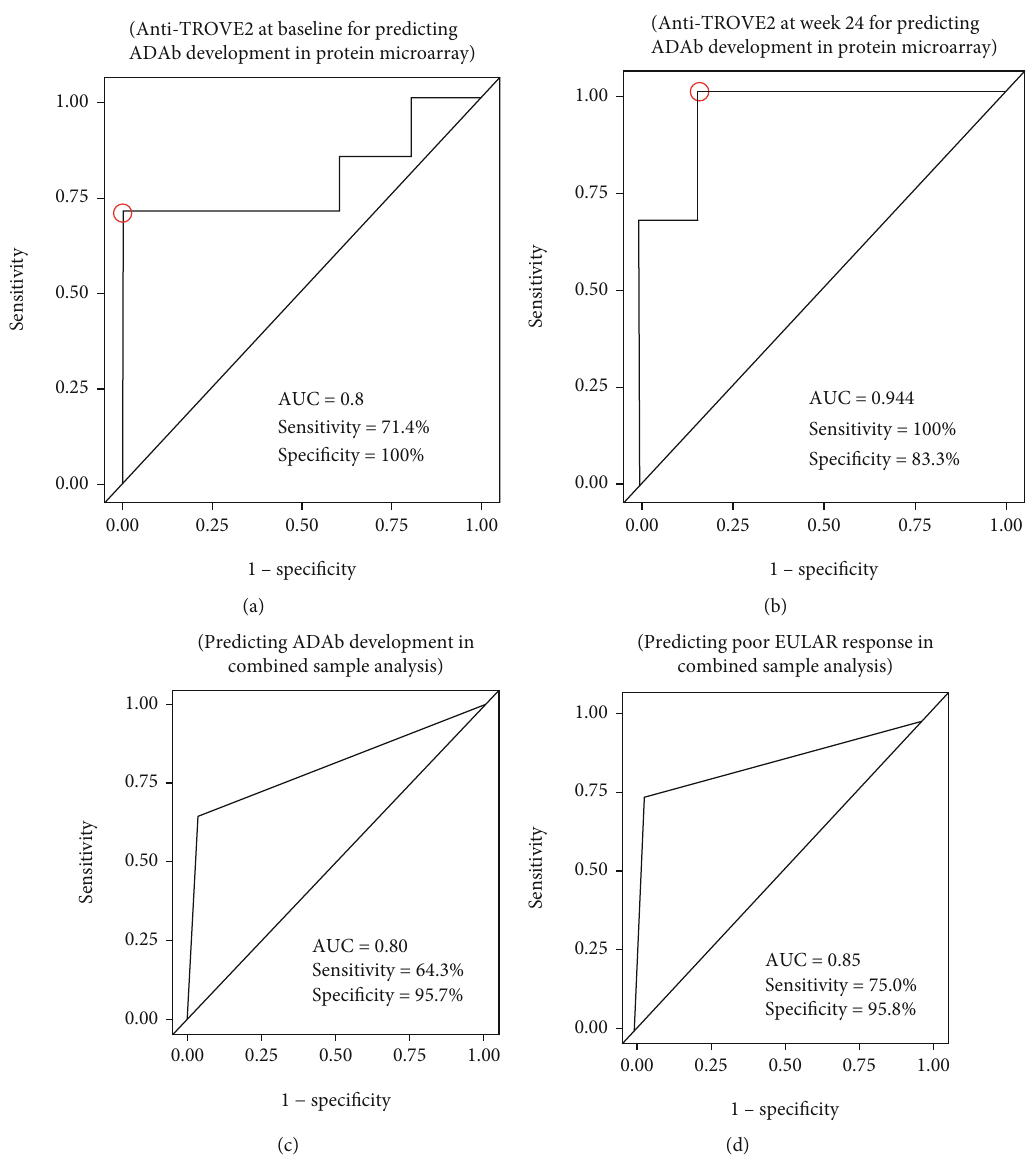
Figure 4: Receiver operating characteristic (ROC) curve analysis of the candidate biomarker, anti-TROVE2 (Ro60/SSA) antibody, either (a) at baseline or (b) at week 24 for predicting the emergence of anti-drug antibody (ADAb) in protein microarray. ROC curve analysis of anti- Ro60/SSA antibody at baseline for predicting the emergence of (c) ADAb or (d) poor EULAR response in combined sample analysis. AUC: area under ROC curve. Poor EULAR responders are de fi ned as patients who have either Δ DAS28 < 0 : 6 or a DAS28 > 5 : 1 assessed at week 24 of adalimumab